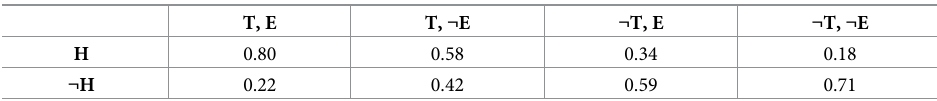
Table 1. Conditional probability